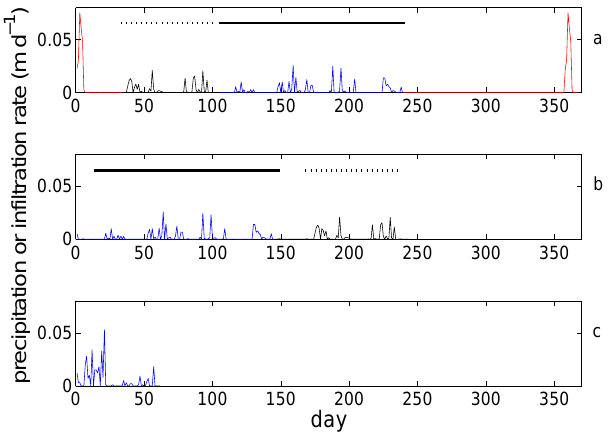
Fig. 2. Precipitation or infiltration rate (a) . 1997 with snowmelt, solute application with a pulse of 6 days, snowmelt from day 1 to 6, length of weather series is 367 days (b) . 1997 without snowmelt, solute application with a pulse of 1 day, length of weather series is 244 days. The lines indicate equal parts of the precipitations series in (a) and (b) . (c) . snowmelt experiment 2010, solute application with a pulse of 1 day, length of weather series is 62 days. The day is the number of days since the first solute application.